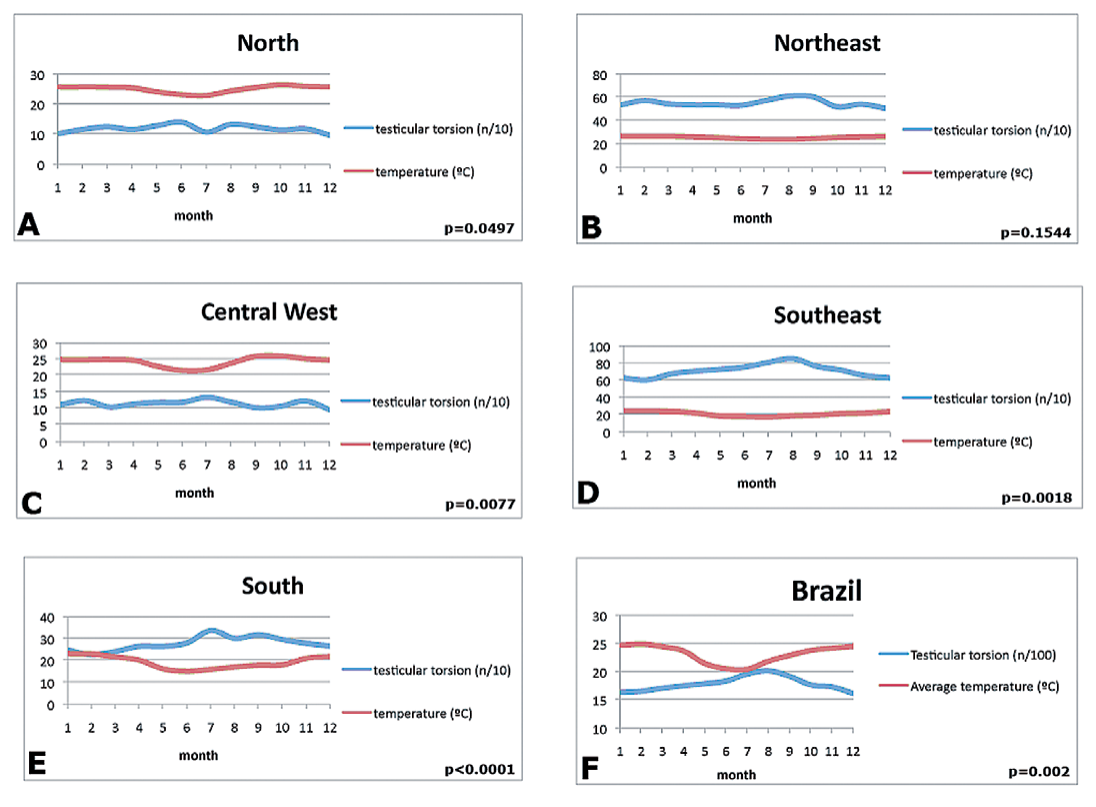
Figure 1 (A-F). A) Distribution of testicular torsion cases in Brazilian public health system from 1992-2010 according to month of the year, average monthly temperature ( o C) and geographic regions (A-E); Brazil